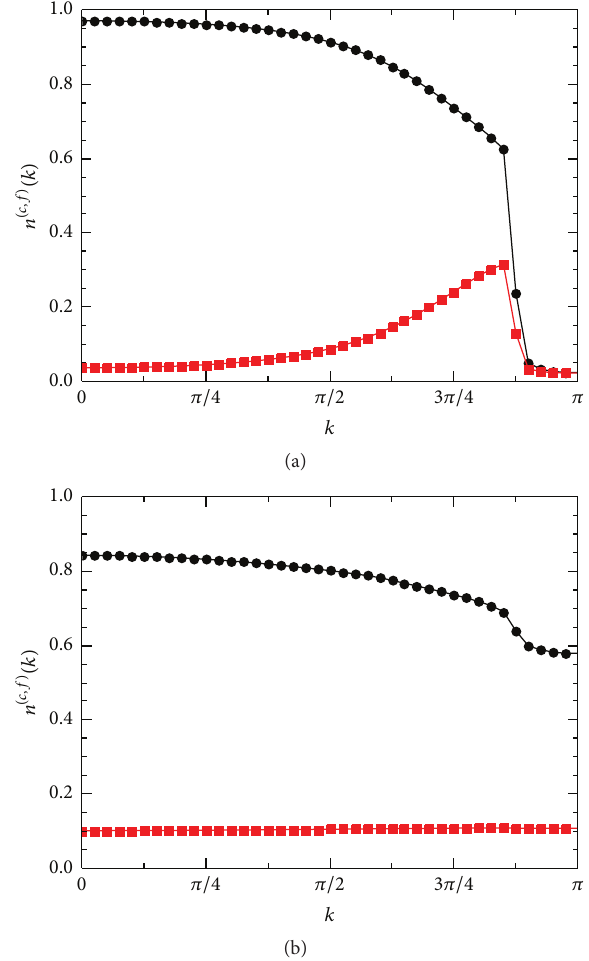
Figure 4: Momentum distribution functions of the conduction (bullet) and 𝑓 (red square) electrons for 𝐿 = 80 and 𝑛 = 1.75 . Panels (a) and (b) correspond to 𝑈 𝑐𝑓 /𝑊 = 0 , 𝜀 𝑓 /𝑊 = 0.5 and /𝑊 = 4 , 𝜀 /𝑊 = −0.75 , respectively; furthermore 𝑈 𝑈 𝑐𝑓 𝑓 and 𝑉/𝑊 = 0.2 in all cases. The lines are guides to the